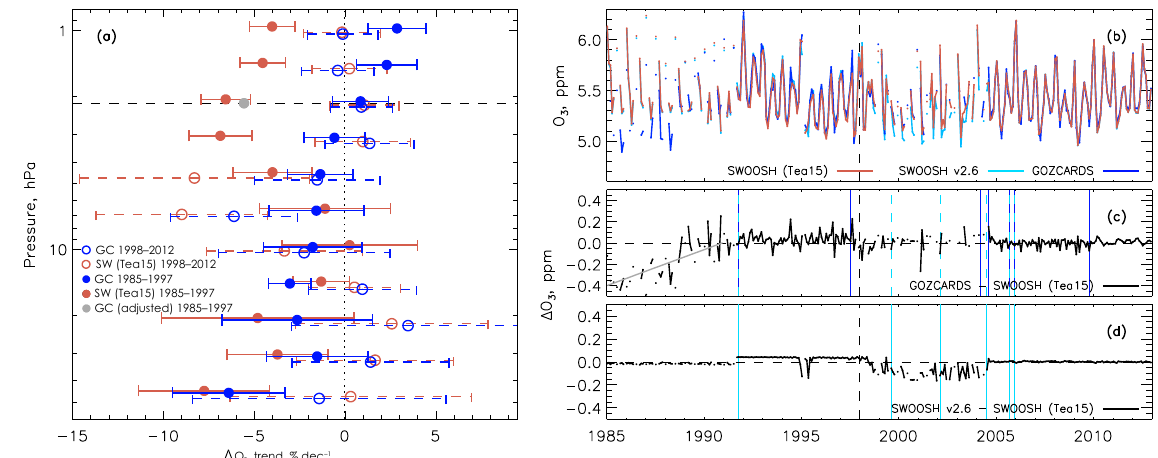
Figure 3. (a) The equatorial (20 ◦ S–20 ◦ N) decadal ozone MLR trend profiles for SWOOSH from Tummon et al. (2015) (“Tea15”; red) and GOZCARDS (blue). Dots and solid error bars represent the 1985–1997 trends, and open circles and dashed error bars the 1998–2012 period. A single grey dot is plotted at 2.2hPa, which follows an adjustment to SWOOSH (Tea15) as shown in panel (c) as a grey line. (b) The ozone composite time series for SWOOSH (Tea15) (black), SWOOSH v2.6 (light blue), and GOZCARDS (blue) at 2.2hPa, all shifted to the July 2005–2012 mean of SWOOSH v2.6. (c) The difference between the GOZCARDS and SWOOSH (Tea15) time series is shown in panel (b) ; the grey line prior to 1991 is an adjustment applied to GOZCARDS to produce the grey dot in panel (a) . (d) The difference of SWOOSH-Tea15 and SWOOSH v2.6. The vertical dashed line in panels (b–d) indicates 1 January 1998, which delimits the two periods considered in the MLR results in panel (a) . Error bars are 2 σ